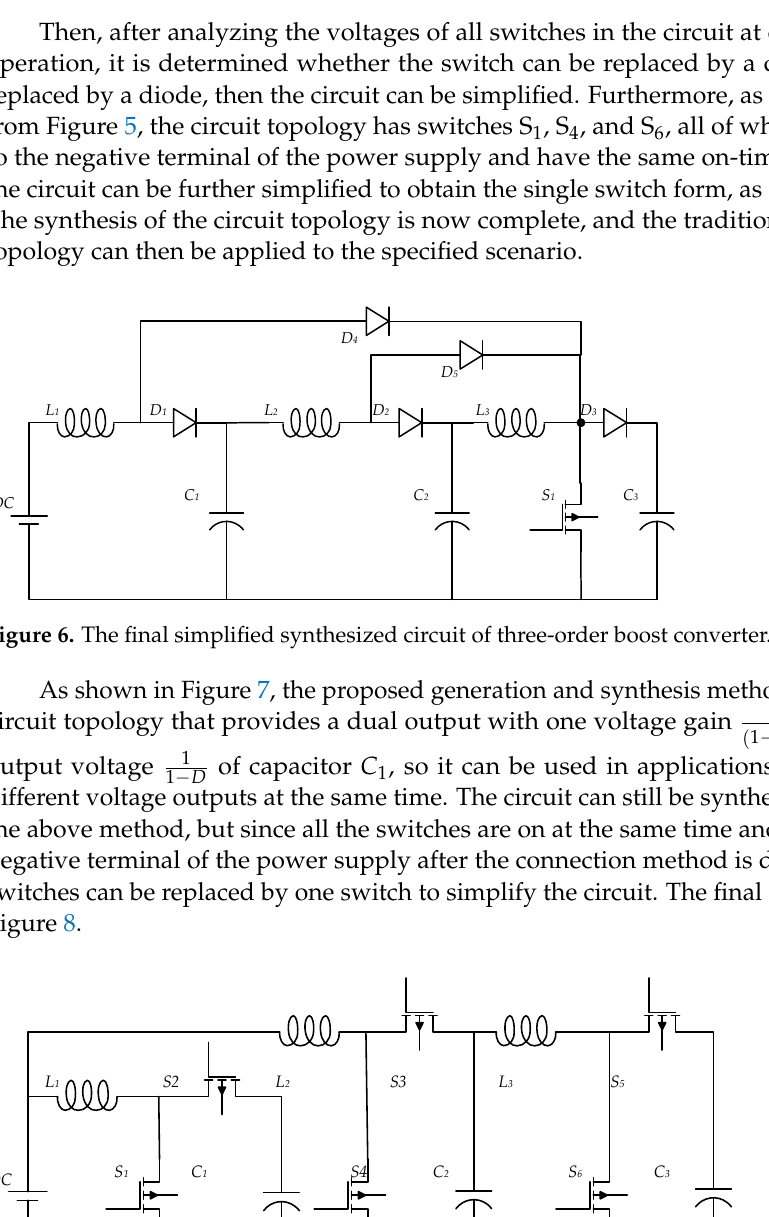
Figure 5. Topology after combination of three-order boost converter.